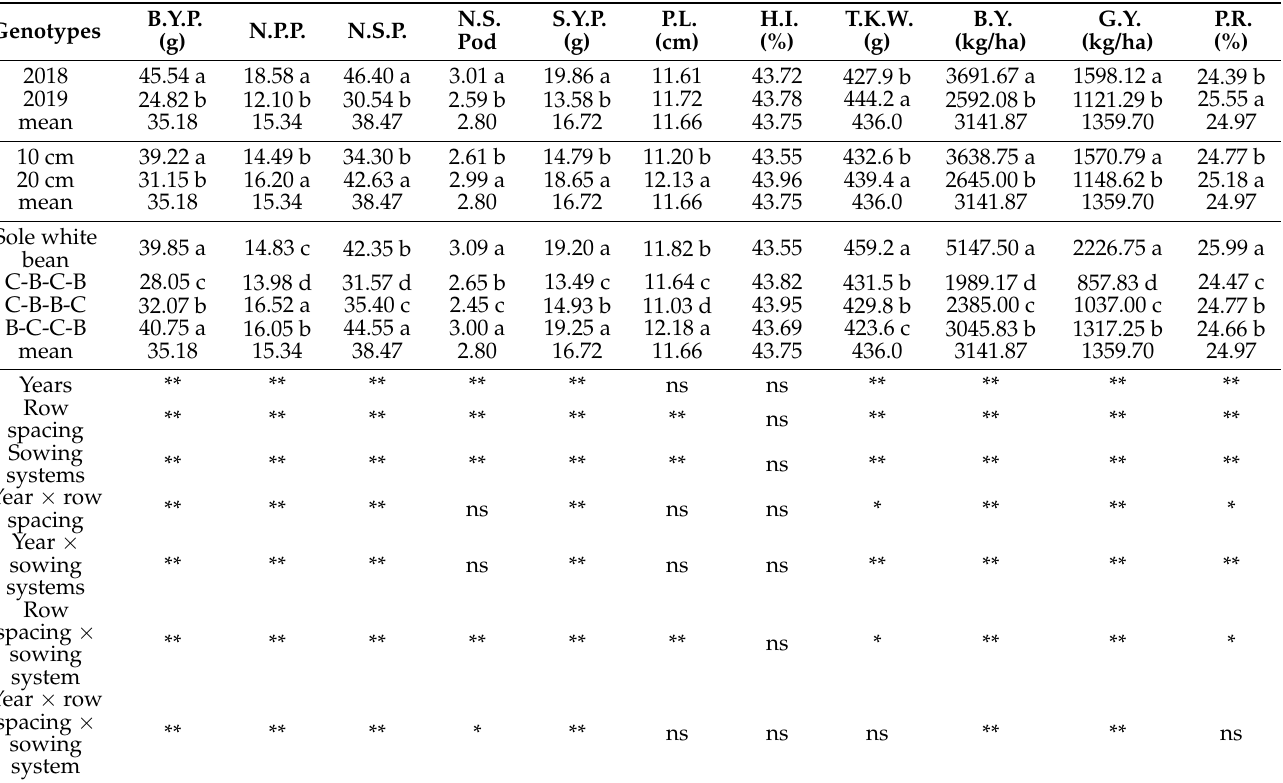
Table 6. Evaluating the effects of different sowing systems on yield characteristics examined in white beans in the study area in Nur Sultan,